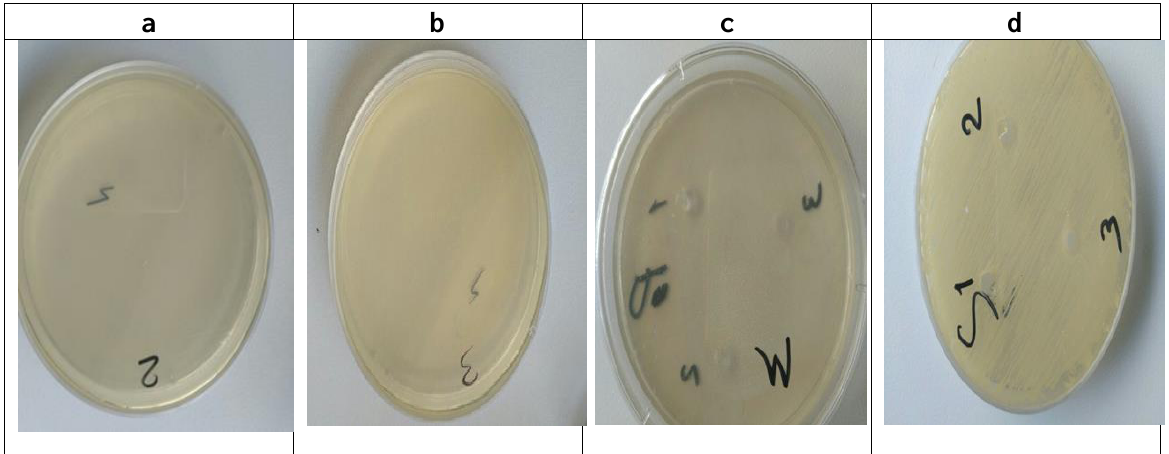
Figure 1.Microbiological assessement of the HUCS on Nutrient Agar (a, b) and Müeller-Hinton Agar (c,